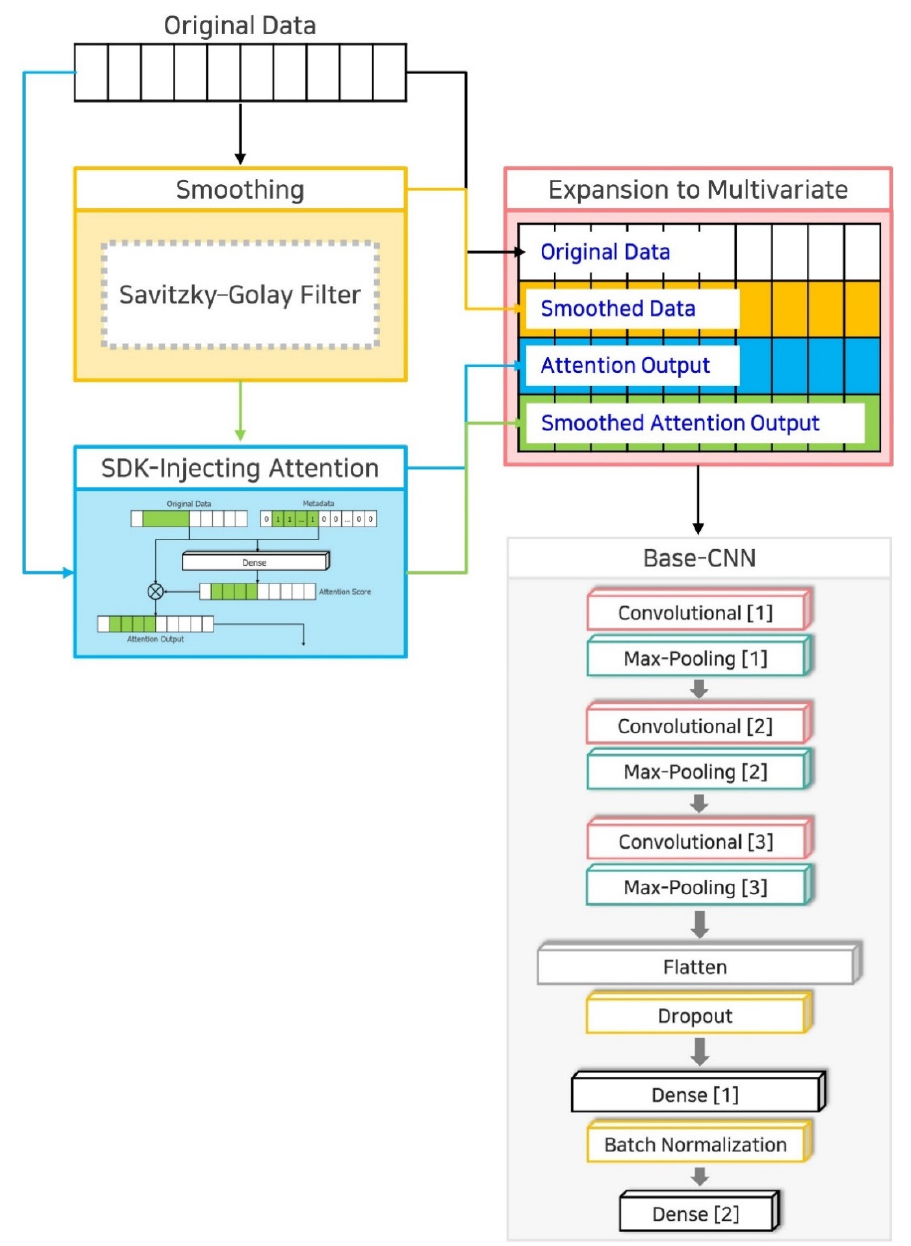
Figure 1. SDK-Injection method proposed in this paper. It takes univariate original data, which is a single ECG stream pattern, and applies three techniques. Technique 1 is curve fitting-based smoothing by Savitzky–Golay filter and Technique 2 is SDK-Injecting attention to inject shallow domain knowledge. Technique 3 is expansion to multivariate, which expands the univariate input to multivariate input by adding three variants generated from the original data by applying Technique 1 and Technique 2. Multivariate input, generated by applying the SDK-Injection method, is passed to the existing parameter-optimized Base-CNN.